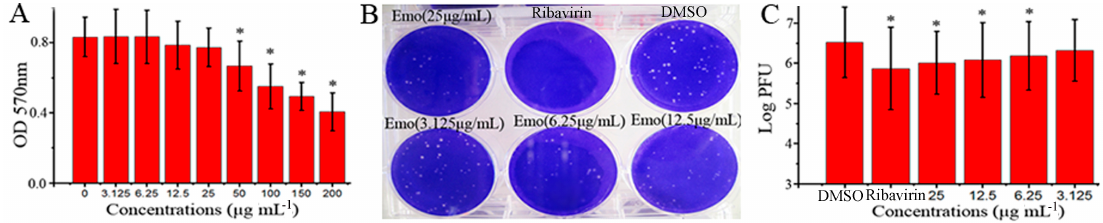
Figure 1. Anti-IAV activity of emodin in vitro. ( A ) The cytotoxicity of emodin on MDCK cells was determined by a MTT method. Data were mean ± SD of five independent experiments performed in triplicate. n = 5, * p < 0.05 vs. the 0 μ g mL − 1 control; ( B , C ) Inhibition of emodin on IAV (ST169) replication was determined by a plaque inhibition assay. In the negative control (DMSO), MDCK cells were infected with IAV (MOI = 0.001) and treated with viral growth medium (VGM) containing 0.5% ( v / v ) DMSO; in the positive drug control (Ribavirin) and emodin-treated (Emo) groups, MDCK cells were infected with IAV and treated with ribavirin (25 μ g mL − 1 ) and emodin (25, 12.5, 6.25 and 3.125 μ g mL − 1 ), respectively. IAV stock solution was beforehand diluted with the drug-contained VGM. After 48 h post infection (p.i.), the supernatants were collected and the titers were determined by a plaque formation assay. Data were mean ± SD of five independent experiments performed in triplicate. n = 5, * p < 0.05 vs. the DMSO control.